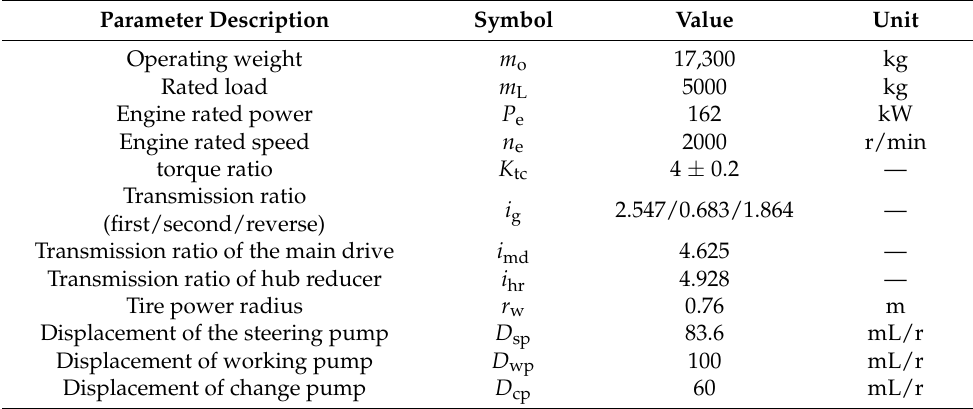
Figure 1. The architecture of the PHHL propulsion system. Table 1. Key parameters of the 956T (conventional version of the